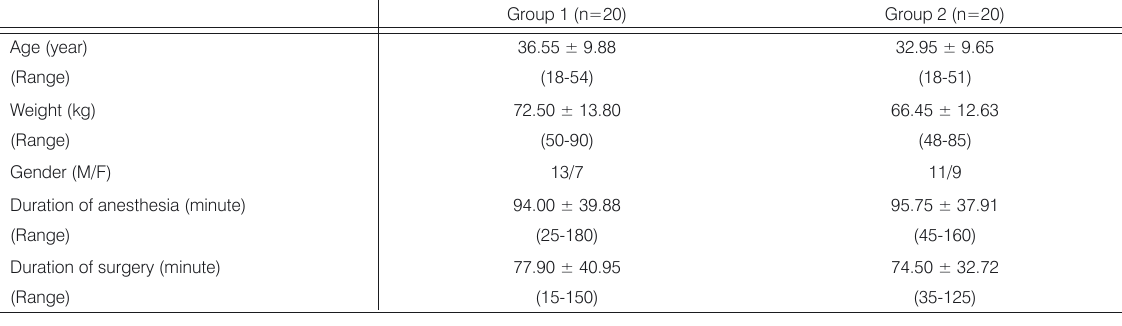
Figure 1. Comparison of mean arterial pressure between the groups Figure 2. Comparison of mean heart rates between the groups (Mean ± SD). (T1: preoperative, T2: before induction, T3: (Mean ± SD). (T1: preoperative, T2: before induction,